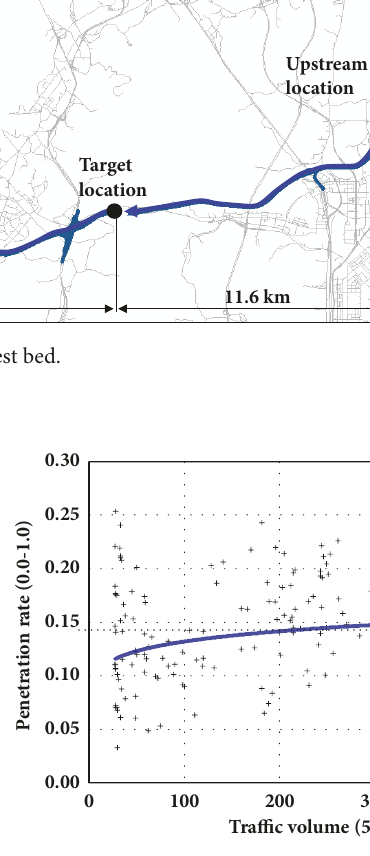
Figure 5: Penetration rate according to traffic